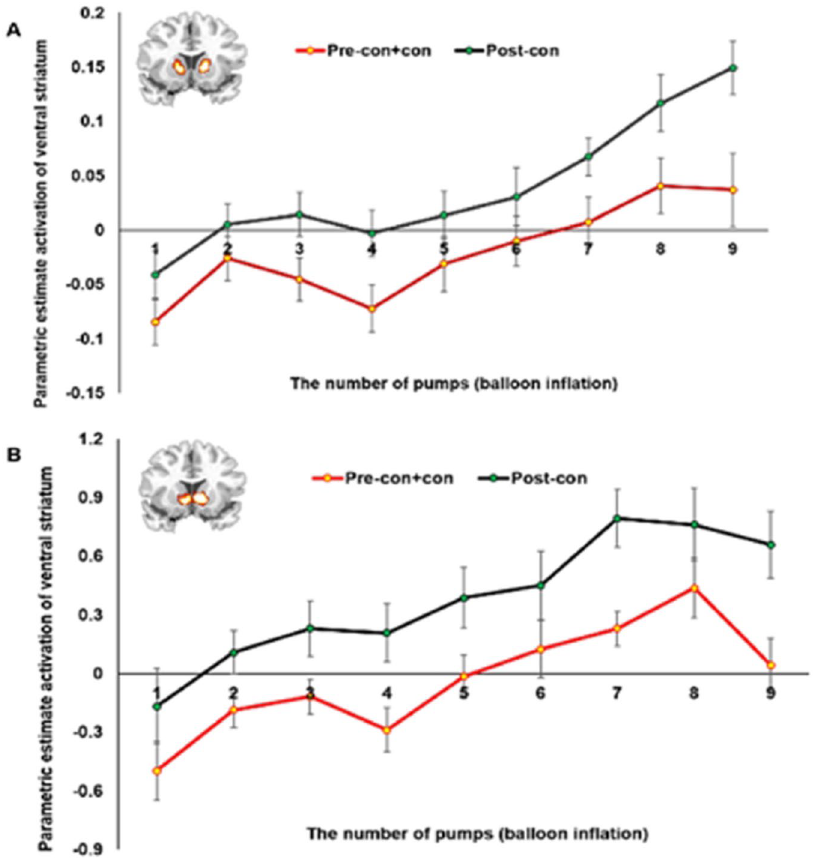
Figure 3. Ventral striatal activation associated with gradually increased risk level in both groups during the BART. ( A ) The functional ventral striatum (VS) ROI was defined based on the CBF results and used to extract VS activation associated with the 9 risk levels. Both groups showed increased brain activation in VS associated with higher risk levels. The post-con group consistently had greater activation across all risk levels (range 1 to 9) compared to the pre-con + con group, and a repeated measures ANOVA revealed a significant main effect between the two groups (F = 5.492, p = 0.018). ( B ) The independent VS ROI was defined based on